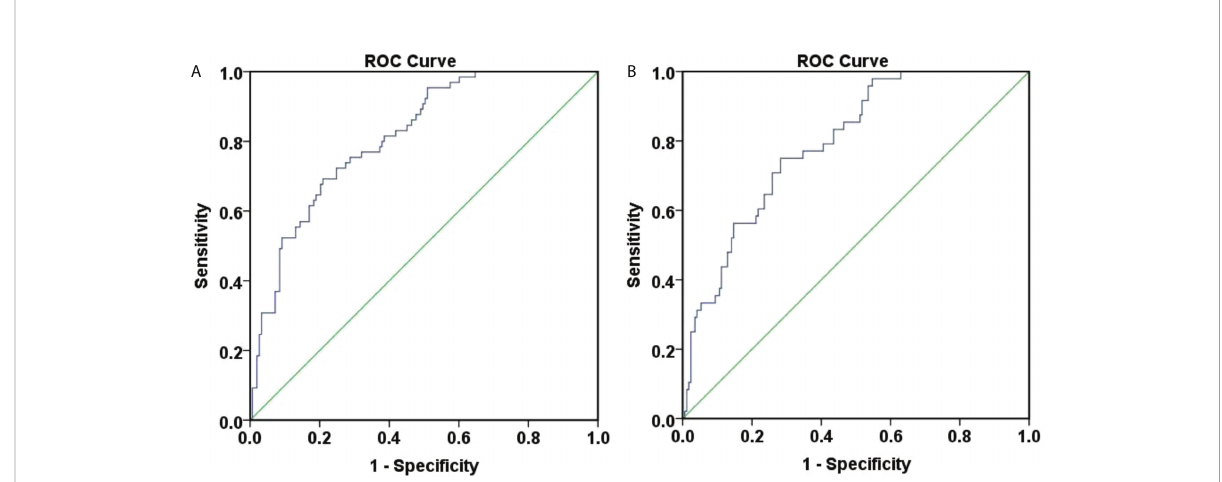
FIGURE 3 ROC curve for predicting 48-week HBsAg clearance and seroconversion. (A) ROC curve for predicting 48-week HBsAg clearance. The area under the curve was 0.814, 95% CI (0.756, 0.872), and the accuracy was good. The best cut-off value for the P value was 0.401, the Youden index was 0.483, the sensitivity was 0.692, and the speci fi city was 0.791; (B) ROC curve for predicting 48-week HBsAg seroconversion. The area under the curve was 0.794, 95% CI (0.729, 0.859), and the accuracy was good. The best cut-off value for the P value was 0.258, the Youden index was 0.468, the sensitivity was 0.750, and the speci fi city was